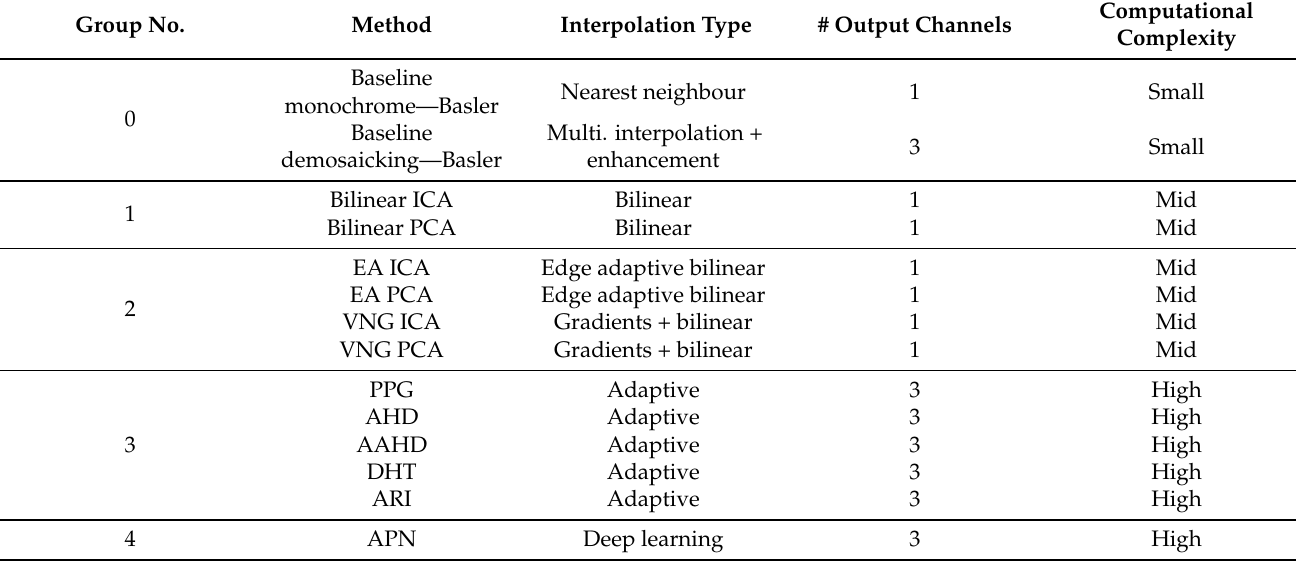
Table 1. Demosaicking